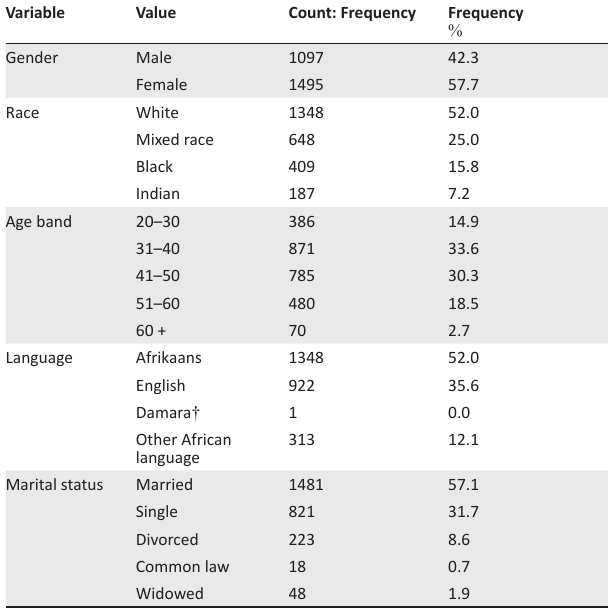
TABLE 1: Demographic characteristics of the sample ( N =